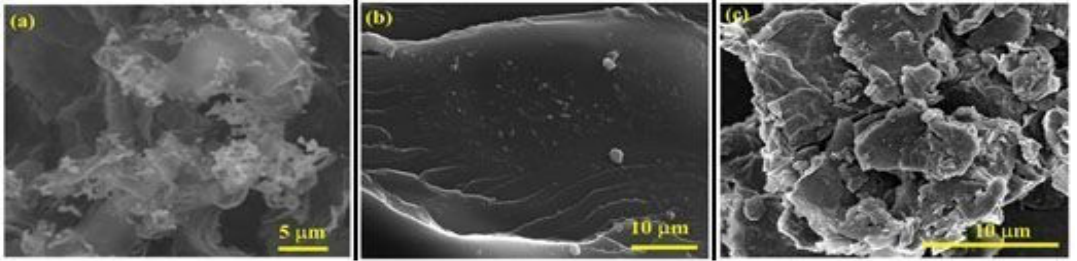
Figure 5. SEM images of ( a ) RGO/AgNPs, ( b ) RGO/AgNPs-(PS-PMMA), and ( c ) R-(GO-(PS-PMMA)- AgNPs.